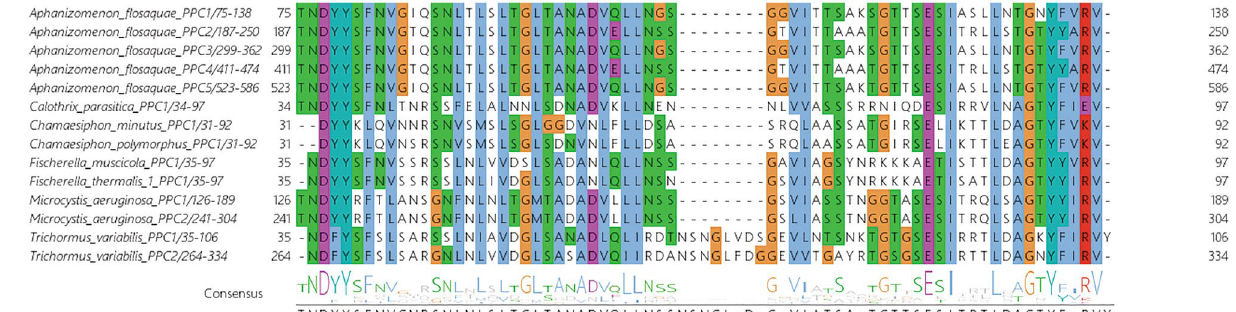
Figure 4. Multiple sequence alignment of PPC domains present in cyanobacterial calpains and the generated sequence logo.